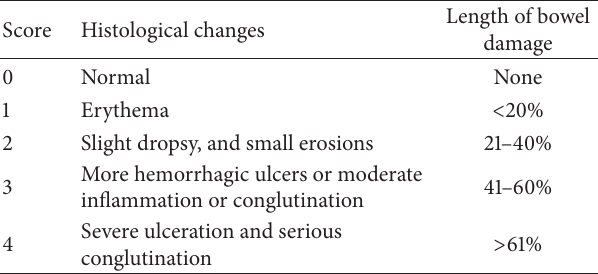
Table 2: Macroscopic evaluation of colonic